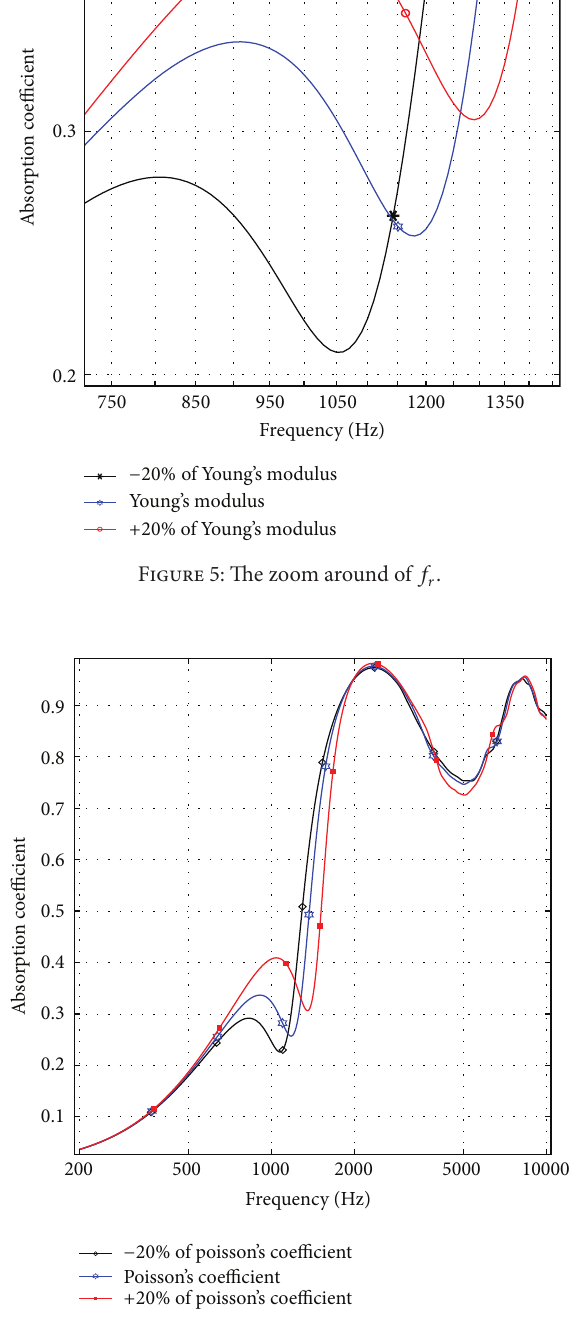
Figure 6: ] effects on absorption